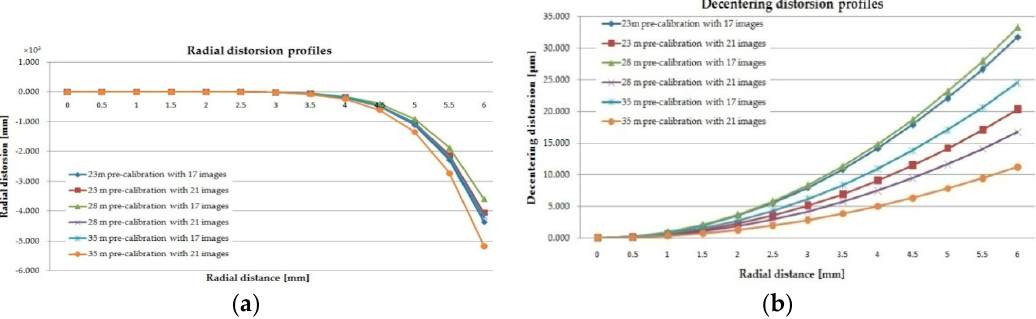
Figure 13. ( a ) Radial and ( b ) decentering distortion profiles for the digital camera mounted on “DJI Phantom 3 Standard” UAS at 23, 28 and 35 m height for 17 oblique images and 21 oblique and nadiral images.